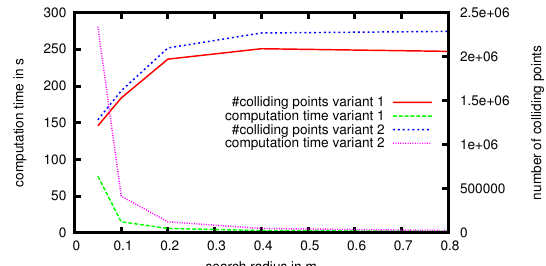
(c) Computation time of both collision detection variants with different search radii r . The distance between individual points on the trajectory d t and the distance between points in the model d m is chosen such that d t = d m = 2